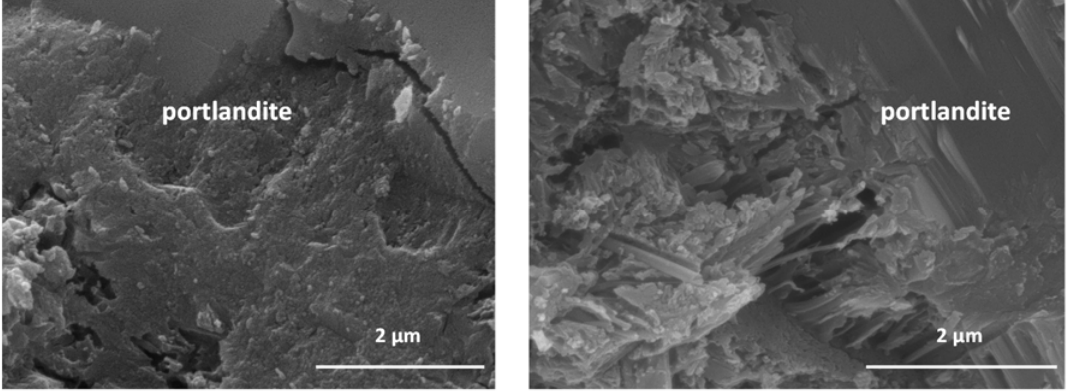
Figure 2. ( Left ) Detail of (2:1) blend compaction. ( Right ) HcG/glass cement.